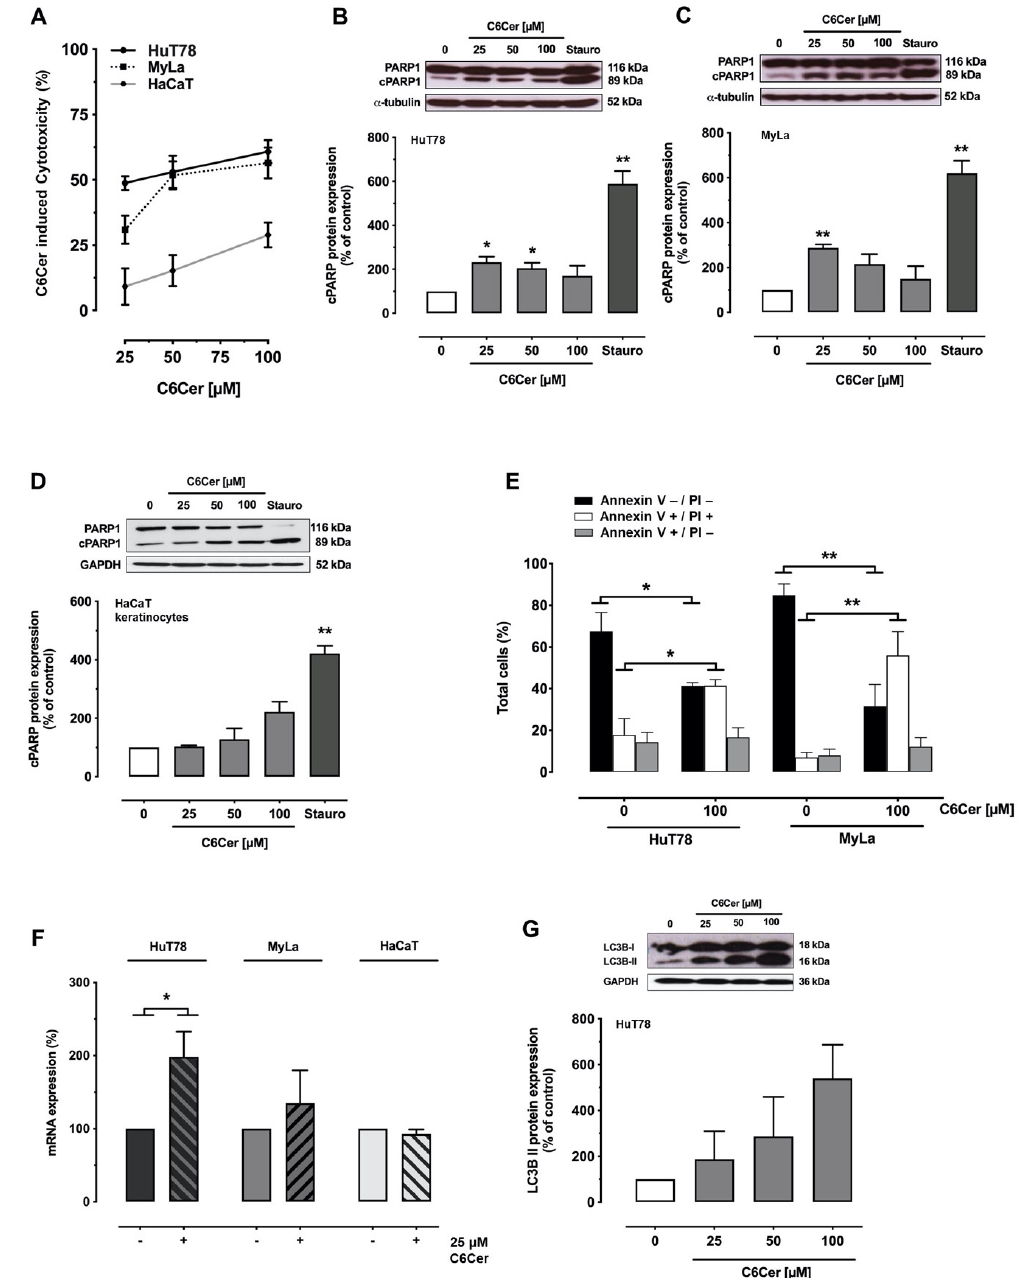
Figure 2. C6 ceramide treatment results in necrosis, apoptosis, and autophagy in cutaneous T cell lymphoma cell lines but not in HaCaT keratinocytes. ( A ): Cells were treated with C6 ceramide (C6Cer) for 24 h and lactate dehydrogenase was measured in the supernatant. ( B – D ): HuT78 ( B ), MyLa ( C ), and HaCaT ( D ) cells were treated with C6Cer, 1 µM staurosporine (STS), or vehicle for 24 h and poly (ADP-ribose) polymerase-1 (PARP1) cleavage was determined by Western Blot. ( E ): Cells were treated with C6Cer or vehicle for 24 h and cells analyzed by flow cytometry after Annexin V (ANXA5) and propidium iodide (PI) staining. ANXA5-, PI-: Healthy cells; ANXA5+, PI+: Late apoptotic or necrotic cells; ANXA5+, PI-: Early apoptotic cells. ( F ): Cells were treated with C6Cer or vehicle for 24 h. Microtubule-associated proteins 1A/1B light chain 3B (LC3B) mRNA expression was determined by TaqMan ® and normalized to the value of the vehicle-treated cells. ( G ): HuT78 cells were stimulated with C6Cer or vehicle for 24 h. LC3B-I and LC3B-II protein expressions were determined by Western Blot analysis. All data are shown as means ± SEM (A–F: n = 3–4; G: n = 2), * p < 0.05, ** p < 0.01. Abbreviations: Glycerinaldehyde-3-phosphate-Dehydrogenase